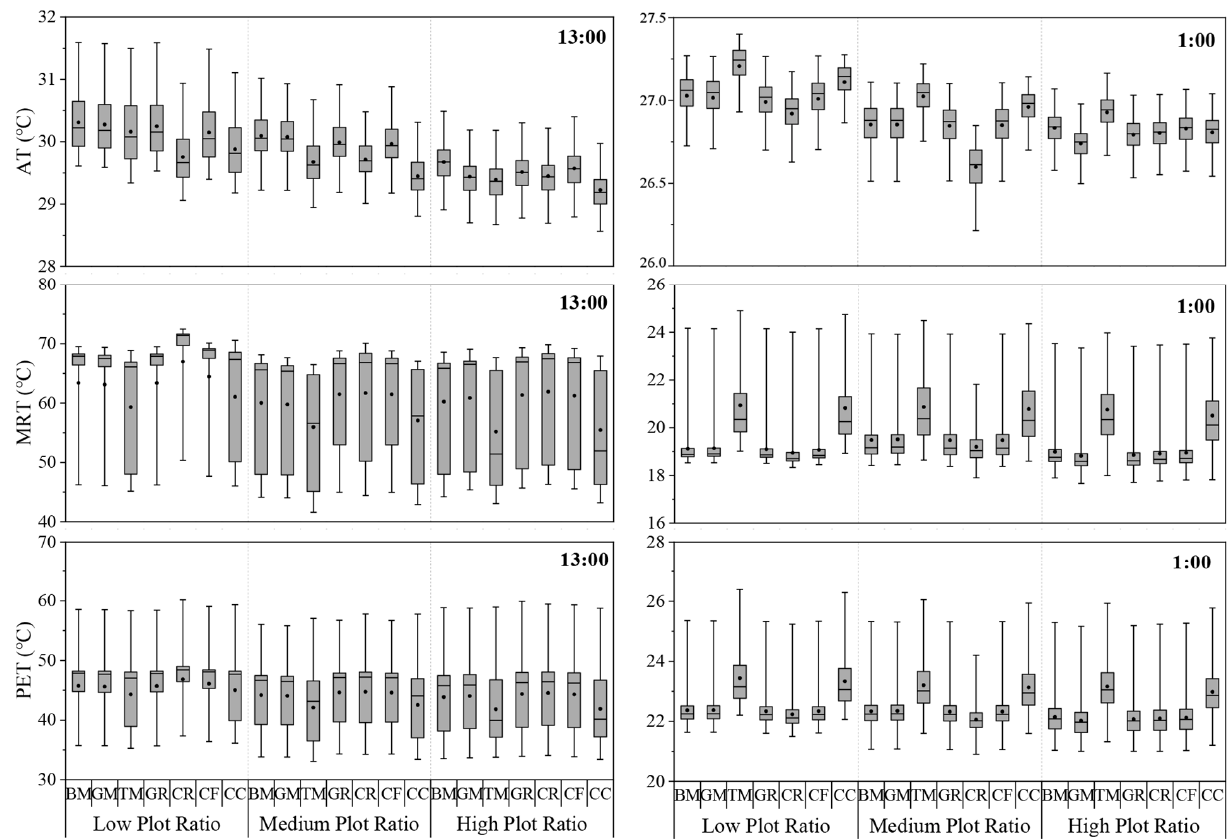
Figure 4. Simulation results of AT, MRT, and PET in pedestrian height (1.5 m) at 13:00 and 1:00, 20